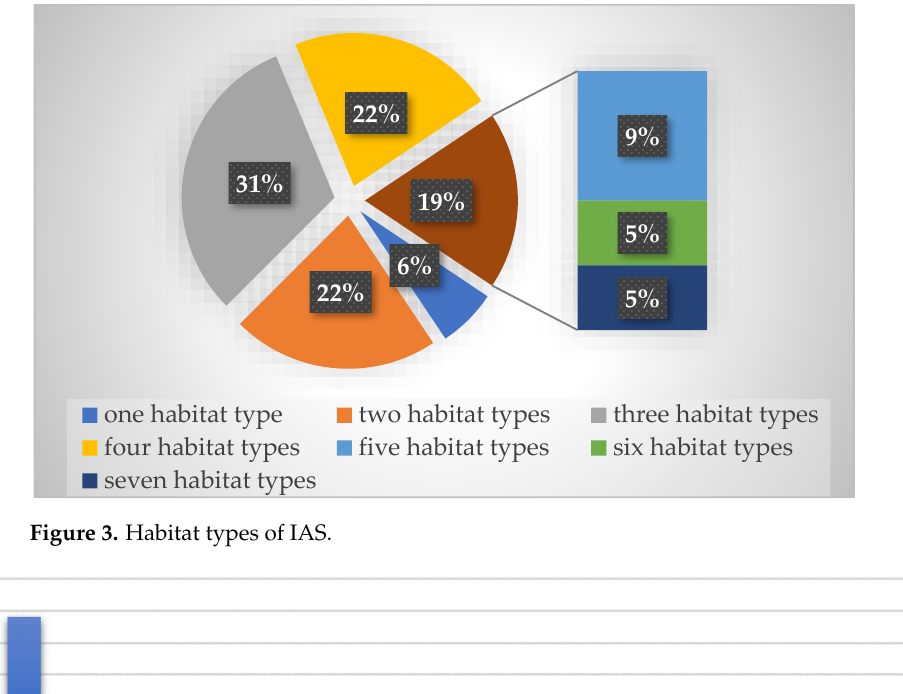
Figure 2. Life forms of IAS.